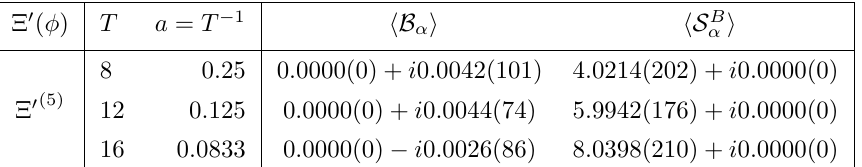
Table 3 . Expectation value of the auxiliary field B α and the bosonic action S B superpotential Ξ 0 (5) . The parameters used are g phys = 3 , m phys = 1 , and µ phys = 4 . 0 .